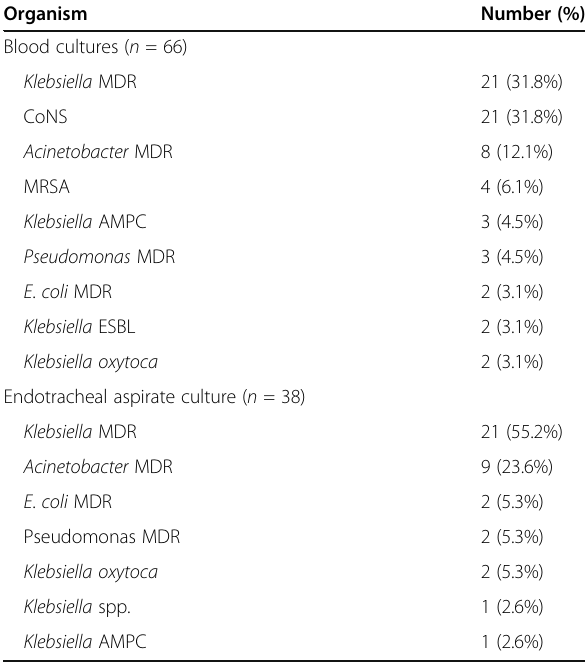
Table 3 Distribution of organisms detected in blood cultures and endotracheal aspirate in the studied neonates Organism